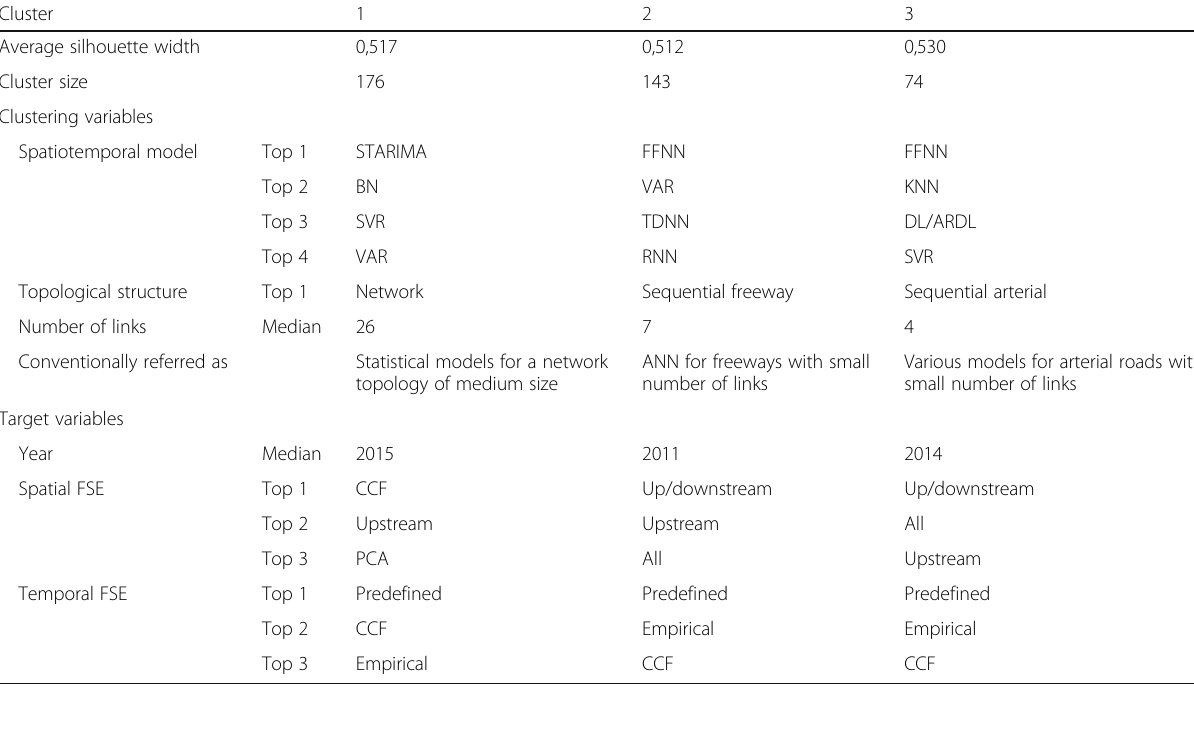
Table 3 Results of bibliographic source clustering